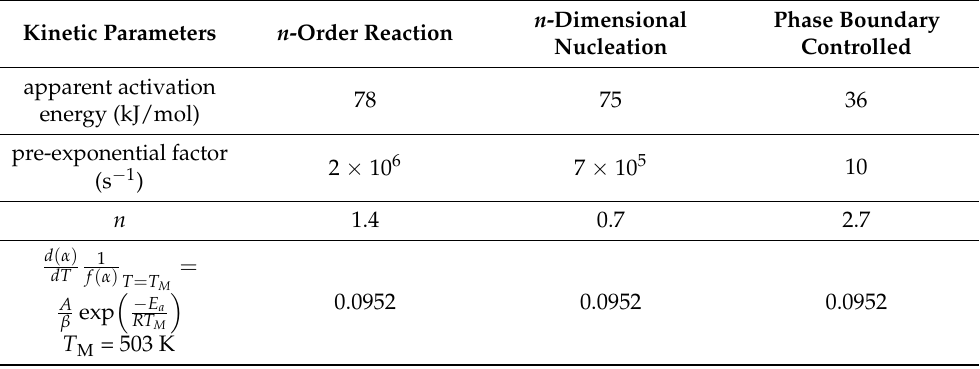
Table 4. Estimated values of the kinetic parameters using different models for the second tion regions occur [45,46], the first to Fe 3 O 4 (that contains Fe 2+ and Fe 3+ ) and FeO (Fe 2+ )